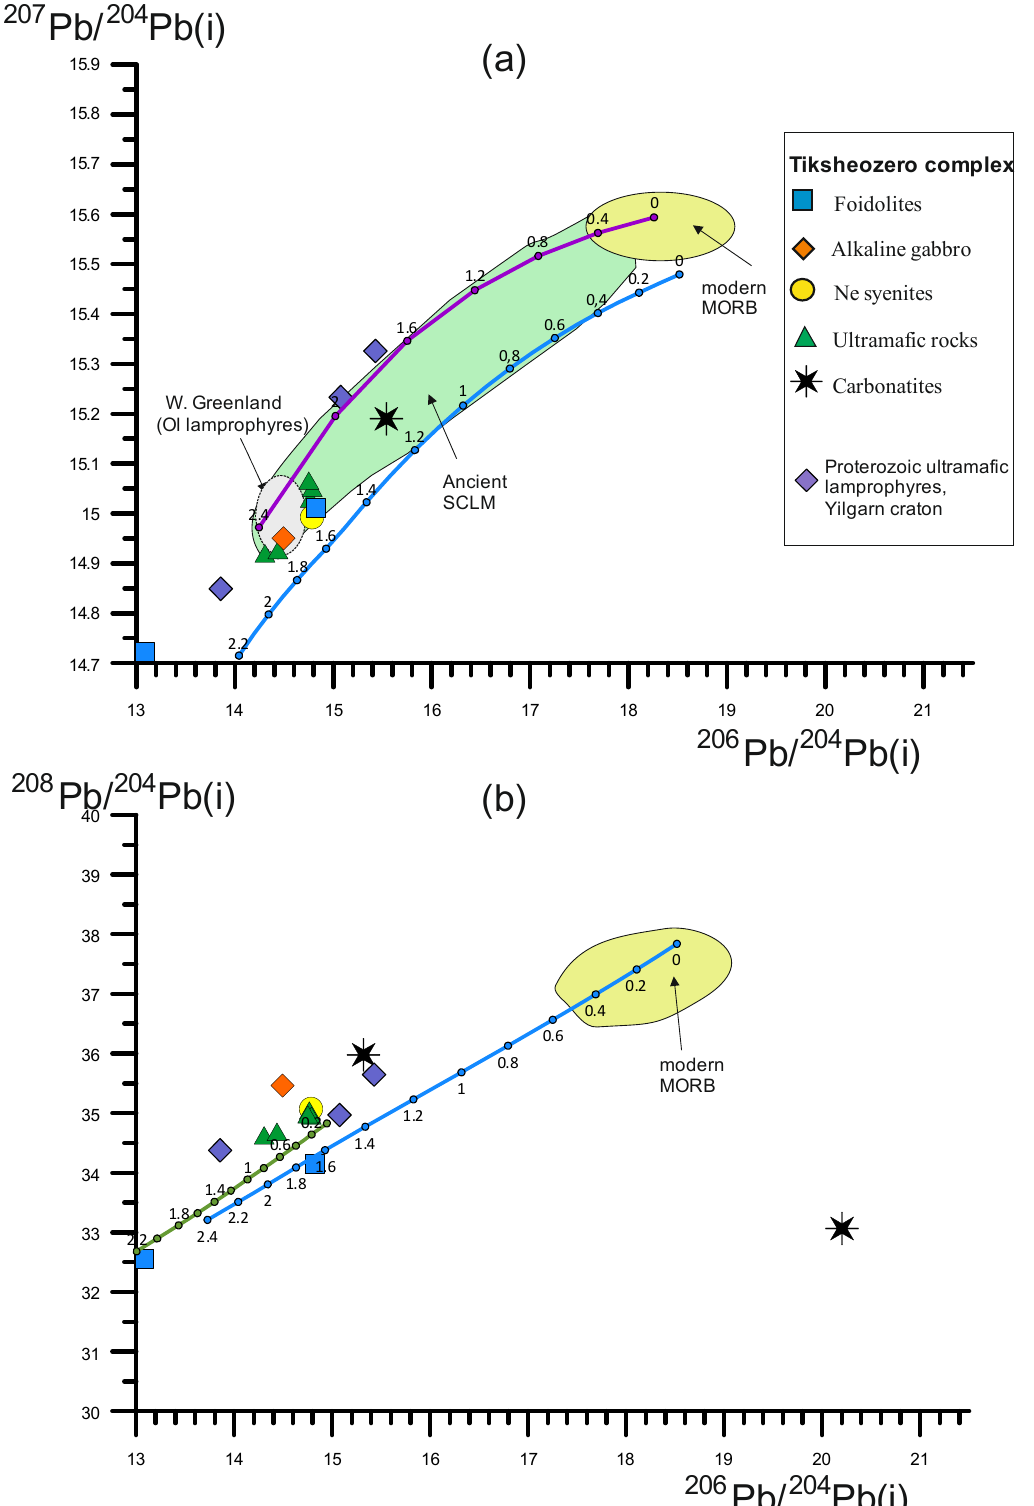
Figure 6. Initial isotope compositions of the rocks of the Tiksheozero complex in the 207 Pb/ 204 Pb- 206 Pb/ 204 Pb ( a ) and 208 Pb/ 206 Pb- 206 Pb/ 204 Pb ( b ) diagrams. Solid blue and green lines are lead isotope evolution curves for depleted upper mantle and old lower crust, respectively, after [41]. The violet solid line shows the lead evolution curve for primitive mantle after [42]. The Proterozoic ultramafic lamprophyres from the Yilgarn Craton [14] and West Greenland lamprophyres [43] are shown for comparison. The compositional field of the ancient SCLM (subcontinental lithospheric mantle) is from [43]. The compositional fields for MORB and OIB are from